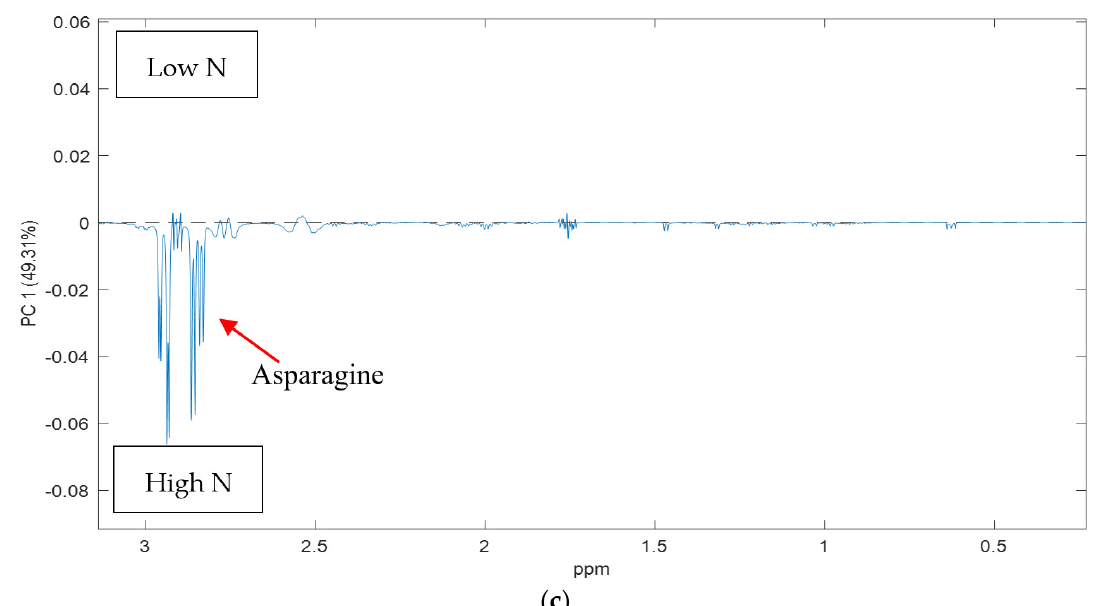
Figure 2. PCA score and loadings plots of 1 H NMR data of Nonpareil hulls: ( a ) PCA scores plot showing clear separation of Nonpareil hull samples based on nitrogen treatment; ( b ) loadings plot of PC1 variables indicates that the high N treatment increased the amino acid content; ( c ) expansion of the loadings plot focusing on the amino acid regions of the spectrum.